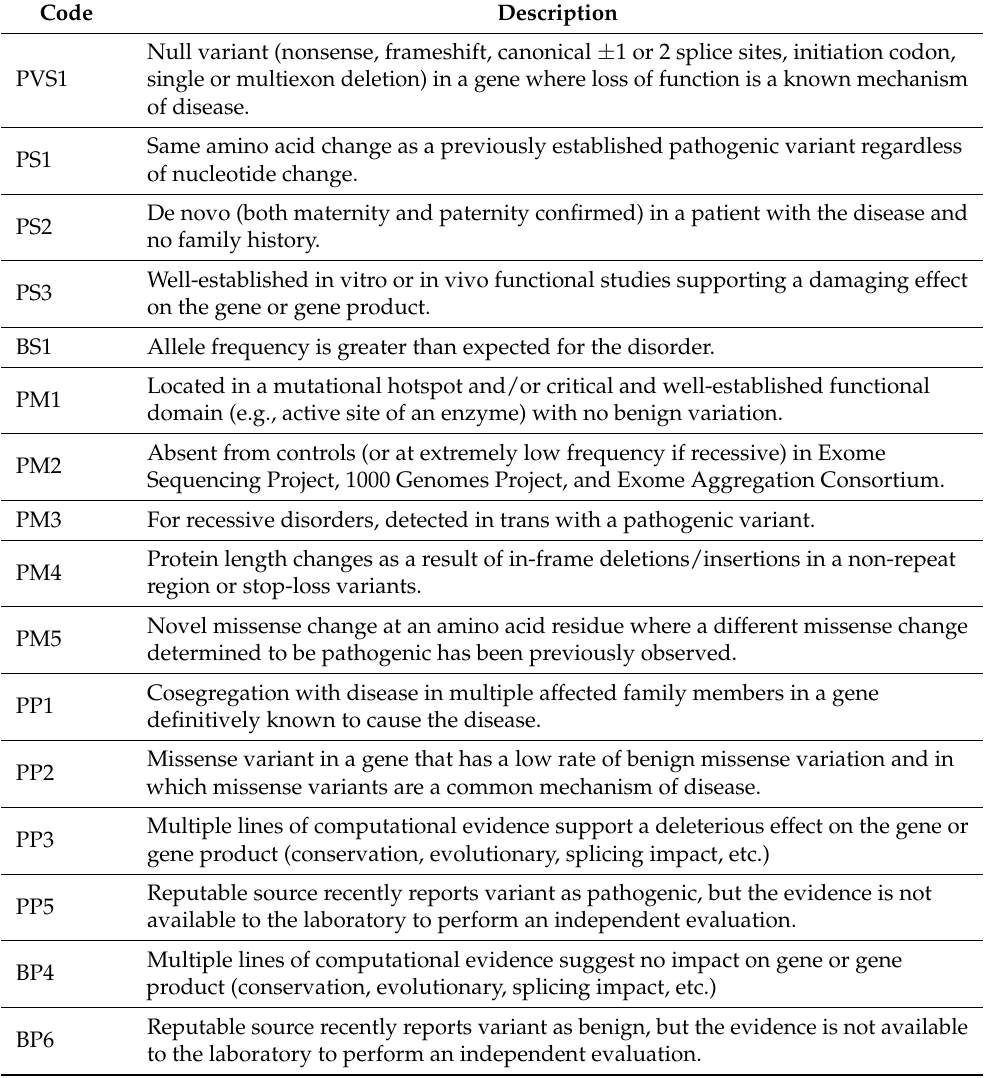
Table A1. American College of Medical Genetics and Genomics criteria.